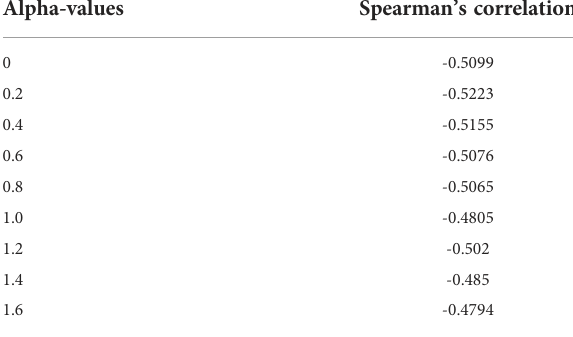
TABLE 2 Signi fi cant correlation between diversity and parasitaemia in P. falciparum infected group.